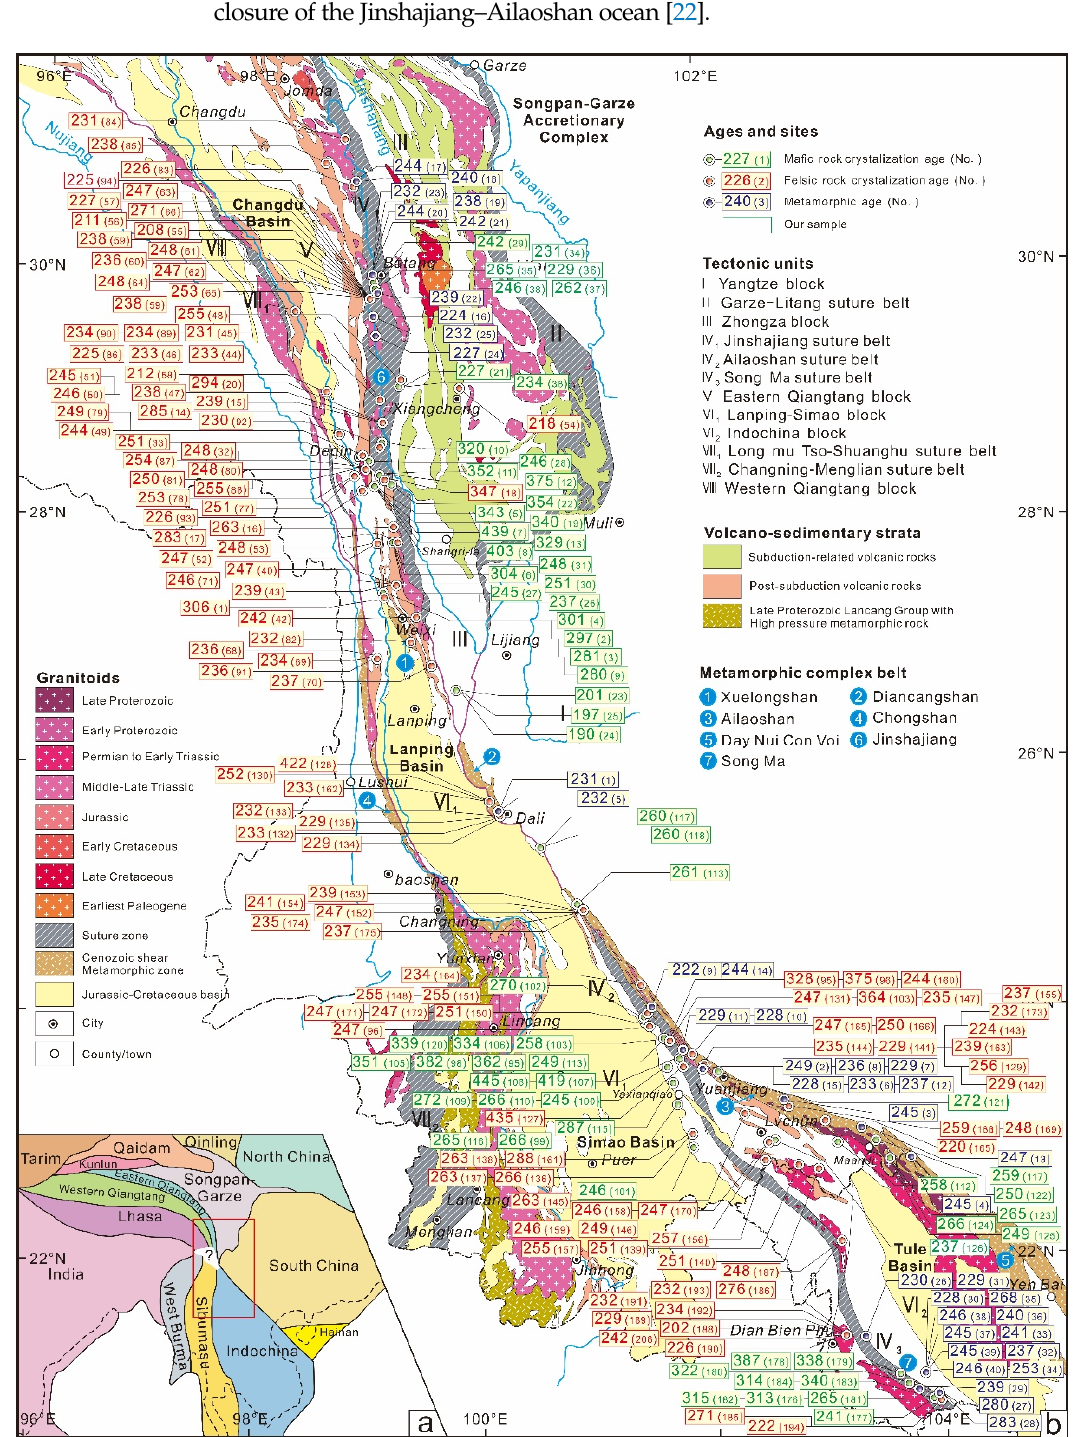
Figure 1. ( a ) Tectonic framework of the southwestern Tibet region; ( b ) Simplified geological map showing the major continental Blocks, suture belts, and the distribution of Ordovician-Triassic magmatic and metamorphic rocks, as well as the location of crystallization and metamorphic ages in the JASB. Revised from Deng et al. [38].